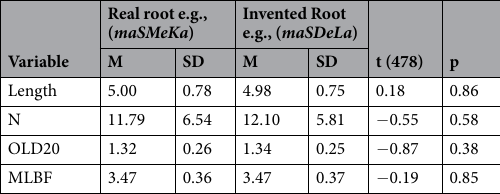
Table 1. Orthographic properties of pseudoword stimuli equated between the two experimental conditions. Length = number of letters; N = number of orthographic neighbors; OLD20 = mean orthographic Levenshtein distance to the 20 closest neighbors; MLBF = mean log bigram